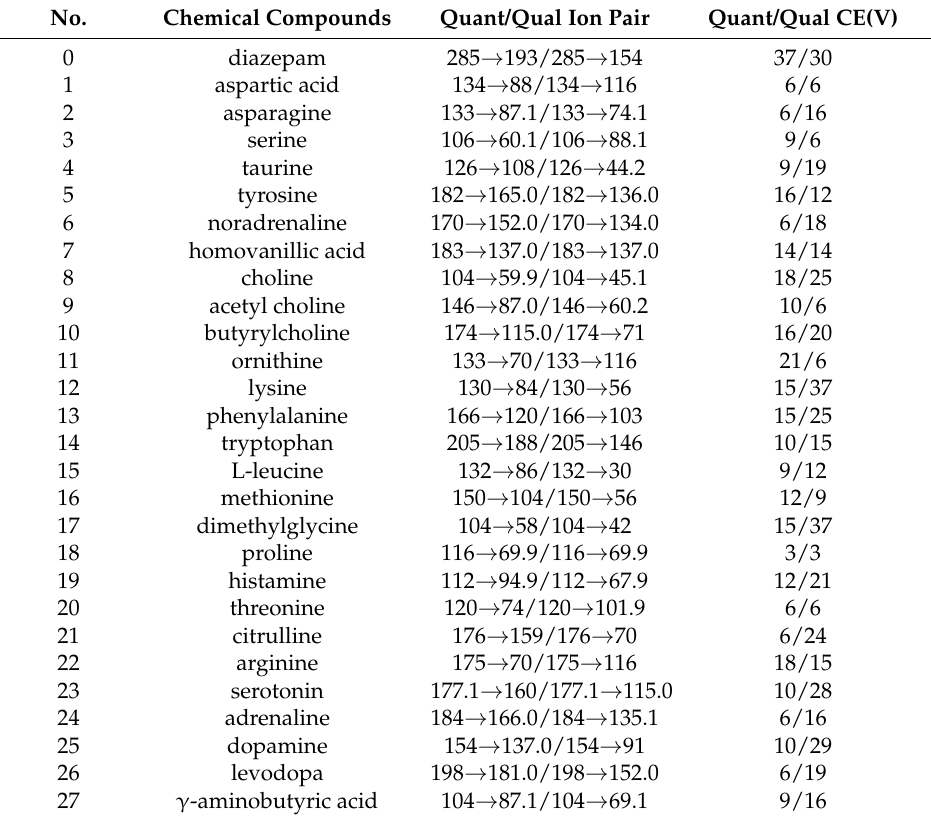
Table 1. Optimized mass transition ion pairs ( m / z ) and CE values for